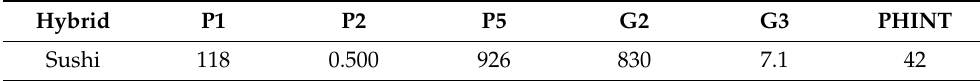
Table 6. Genetic coefficients for the Sushi hybrid. Hybrid